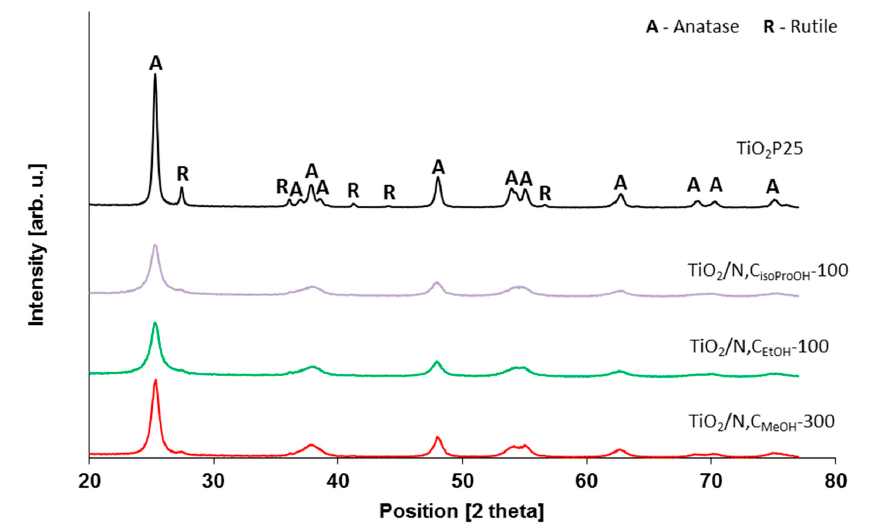
Figure 2. XRD patterns of photocatalysts obtained by using di ff erent alcohols (selected on the basis of the highest antibacterial activity tests).